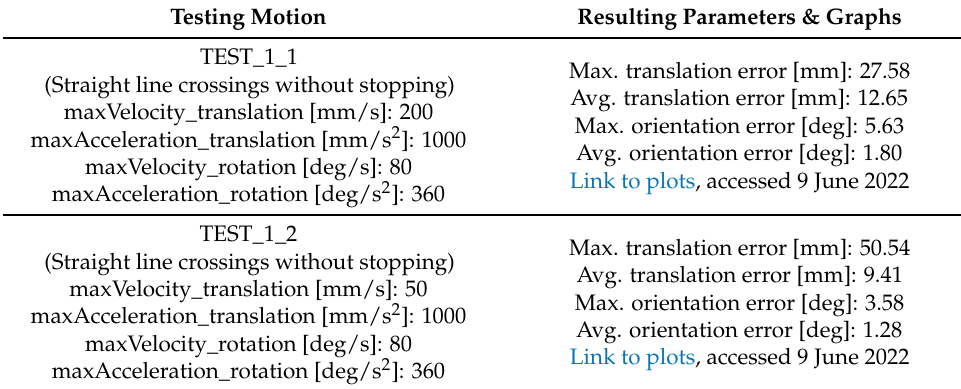
Table A1. Parameters of the executed motion profiles during dynamic